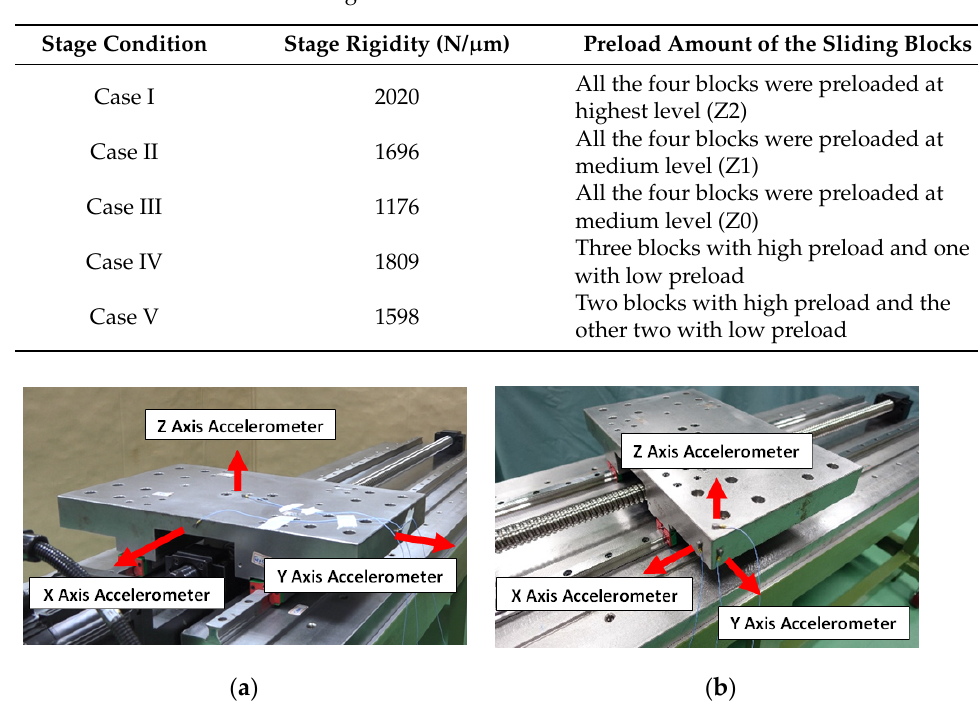
Figure 9. Measurement of the vibration of the stage in feeding motion using three-axial accel- erometers: ( a ) sensors at mid-points and center of stage; and ( b ) sensor at corner of stage. Table 4. Preload conditions of stage for motion tests.